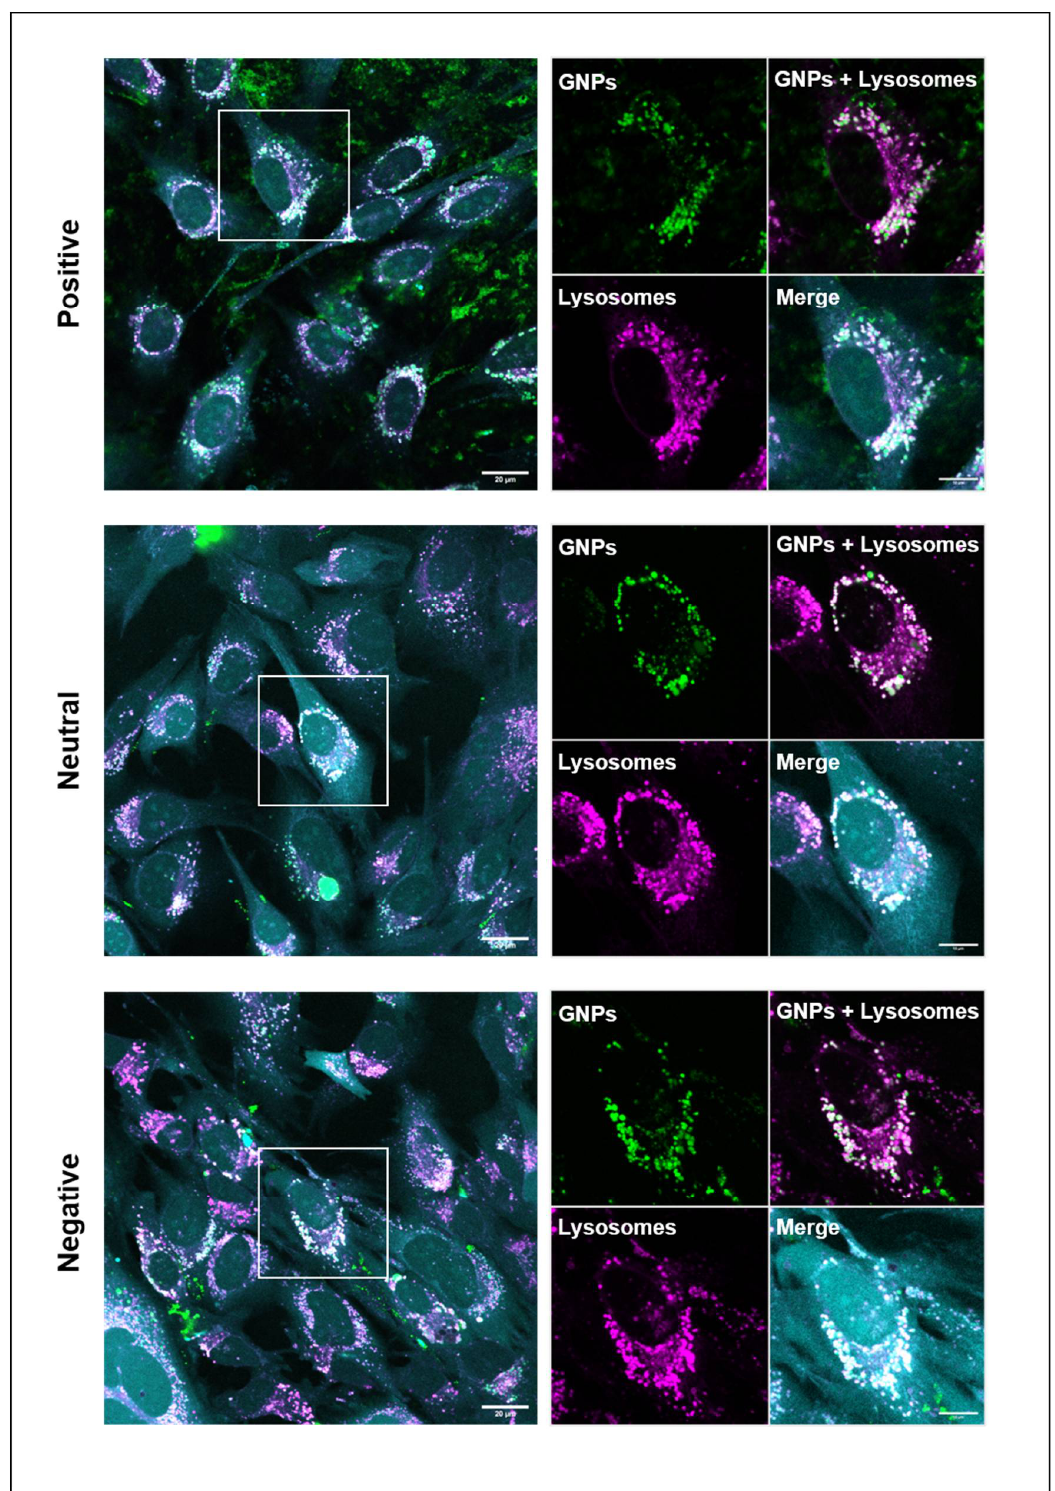
Figure 4. Internalization of gelatin nanoparticles. Confocal live cell images showing internalization after 24 h of differently charged gelatin nanoparticles (green) in mouse pre-osteoblastic cells (cyan) and their localization in lysosomal compartments (magenta) after adjusting image acquisition set- tings to optimize the visibility of each type of GNPs. The co-localization of GNPs and lysosomal compartments appears white. Enlarged region of interest is marked by white squares in the images on the left. Scale bars represent 20 μm and 10 μm (zoom-in image).